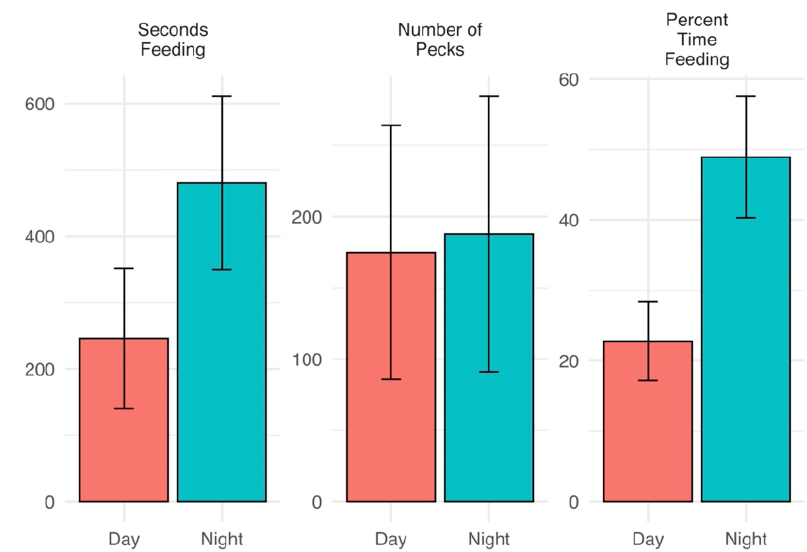
Figure 3. Mean ( ± se) time spent feeding (seconds), numbers of pecks to substrate during feeding, and time budgeted to feeding (percent of observed time) for 12 piping plovers during the 2018 breeding season along Lake Superior, Michigan, USA.